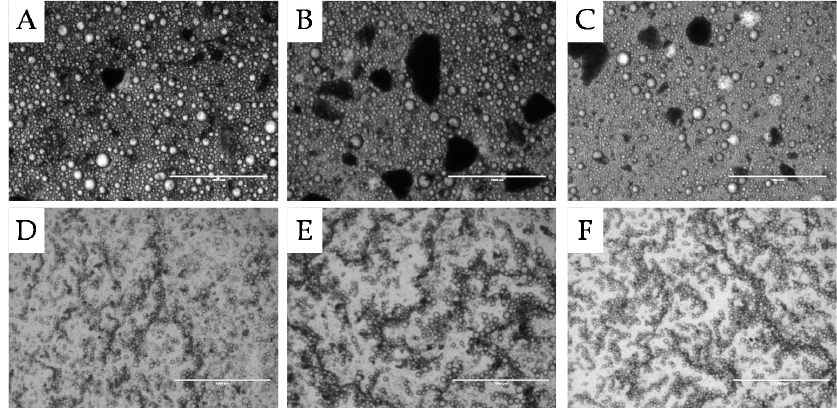
Figure 2. Light micrographs of o/w emulsions with 46% oil and stabilised with 8% unmilled or milled coffee particles with different oil phase polarity acquired after one day of storage at 25 ◦ C. Images are as follows; unmilled coffee particle with an oil phase of ( A ) 100% dodecane (least polar); ( B ) 50% dodecane and 50% IPM (intermediate polarity) and ( C ) 100% IPM (most polar) and milled coffee particles ( D ) 100% dodecane; ( E ) 50% dodecane and 50% IPM and ( F ) 100% IPM. Scale bar represents 1000 μ m.